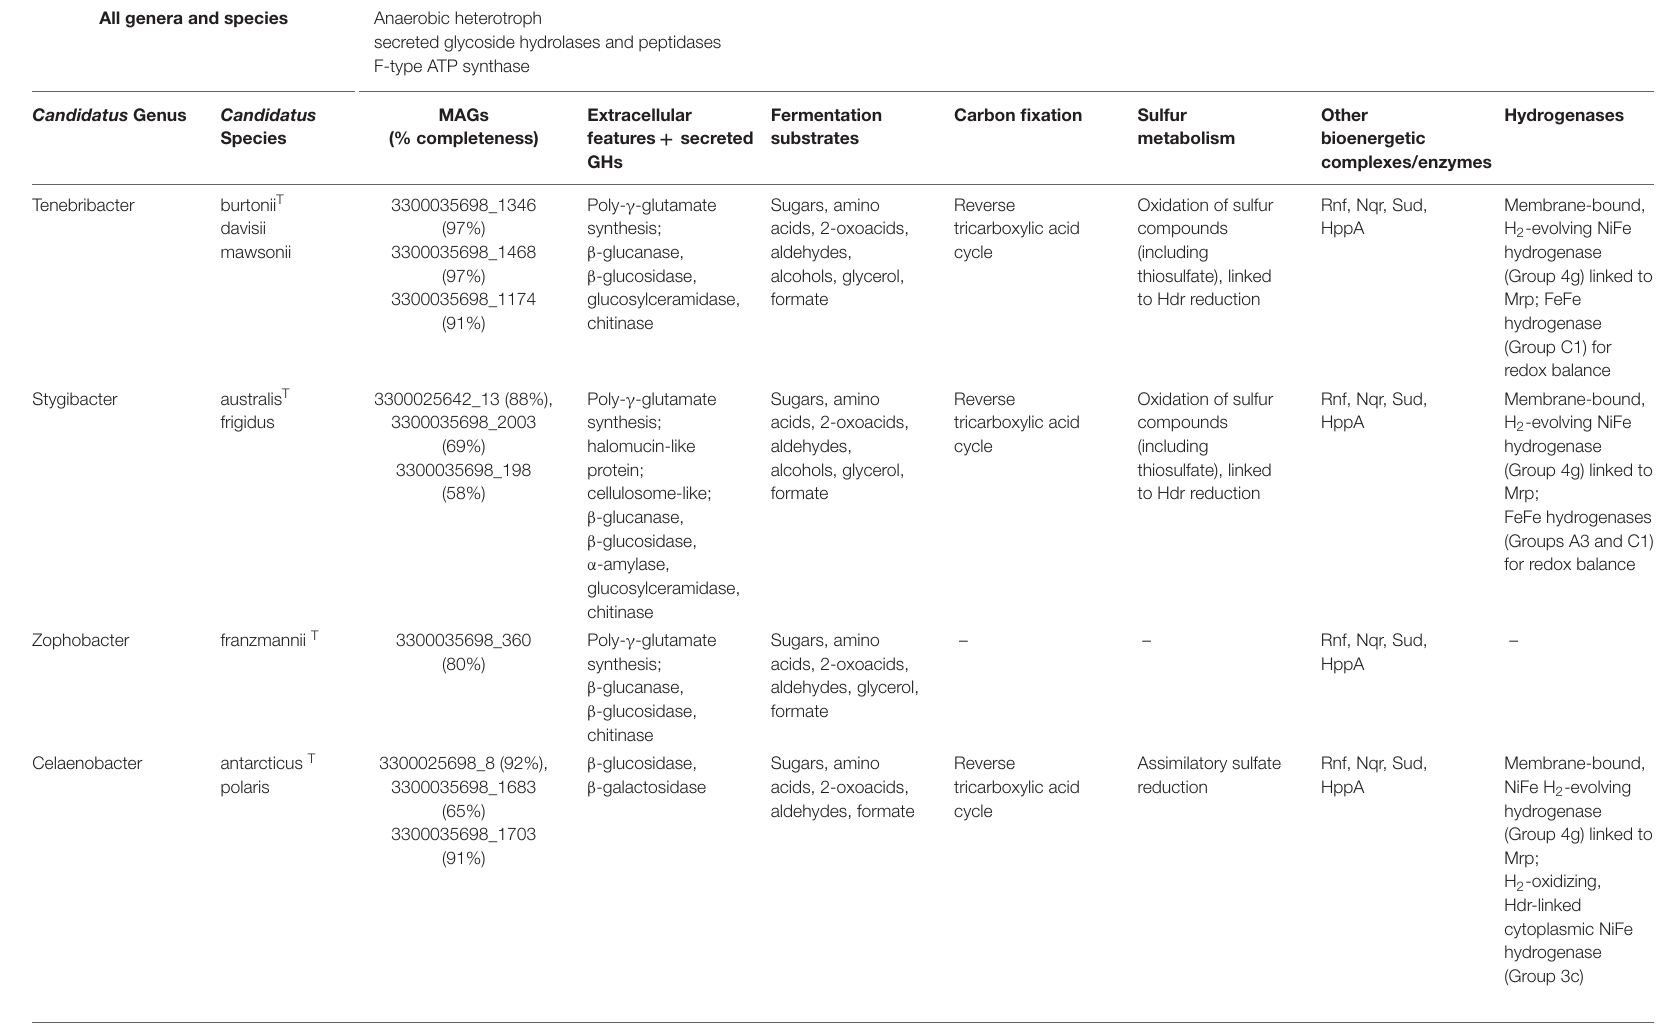
TABLE 1 | Metabolic capacity of the Ace Lake Cloacimonadota inferred from metagenome-assembled genomes